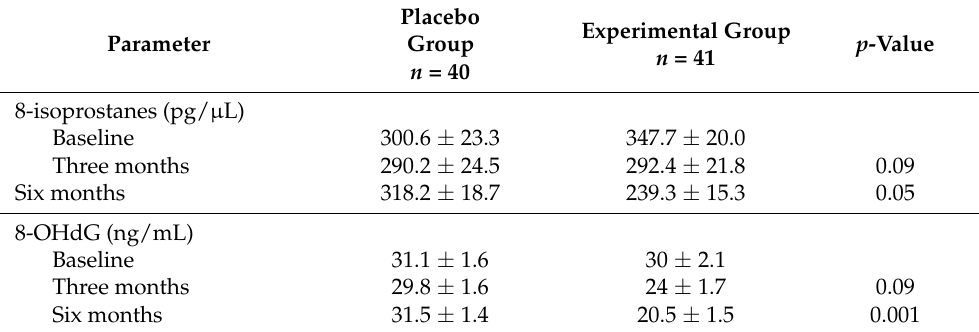
Table 4. Pre- and post-treatment oxidative stress markers by study